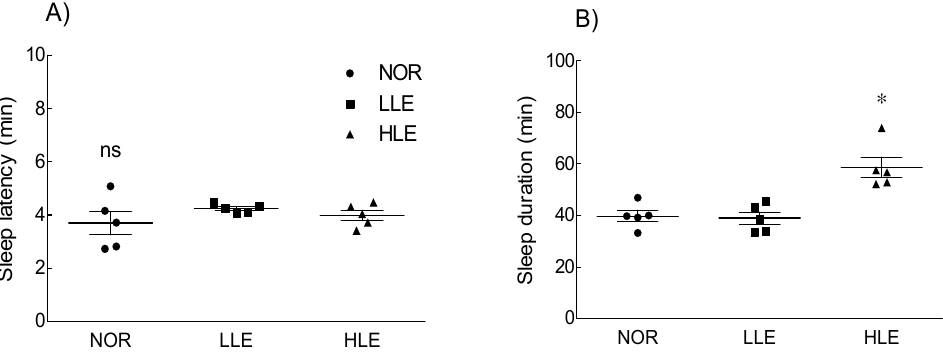
Figure 1. Effects of the ethanol extracts of lotus leaf on ( A ) sleep latency and ( B ) sleep duration in mice ( n = 5/group) intraperitoneally injected with a hypnotic dose of pentobarbital (42 mg/kg). NOR: normal group; LLE: low dose of ethanol-extracted lotus sample-treated group (150 mg/kg); HLE: high dose of ethanol-extracted lotus sample-treated group (300 mg/kg); ns, not significant. Values are means ± standard error of the mean for each group. * p < 0.05 vs. NOR.